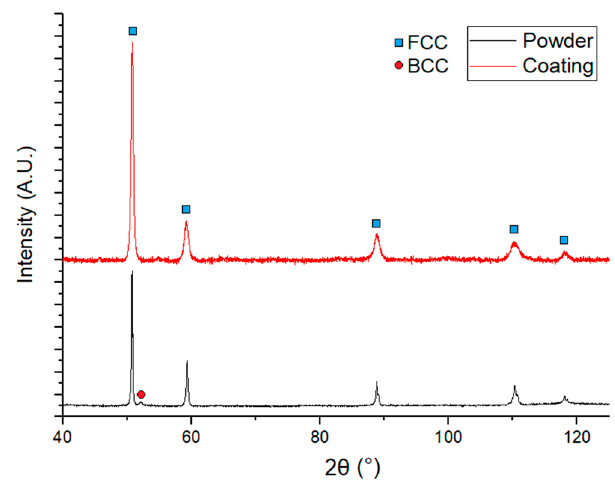
Figure 4. XRD patterns of the coating (#3) surface and the starting powder.